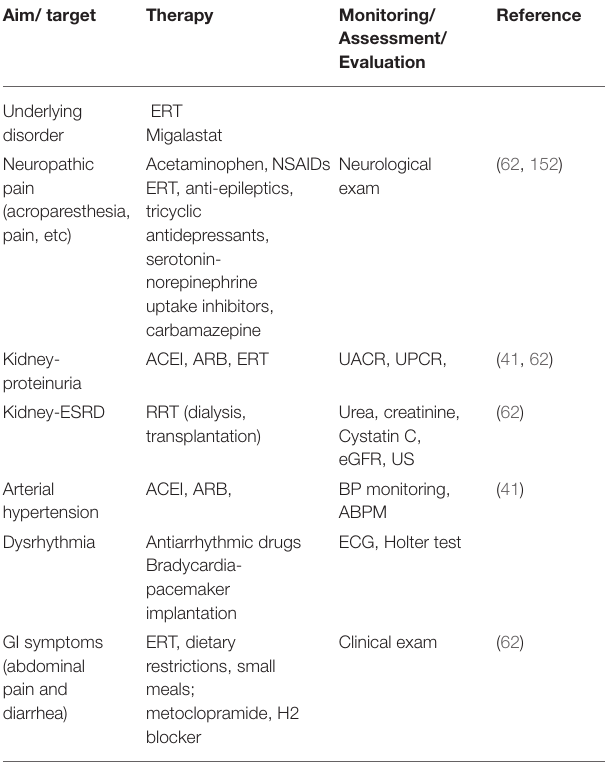
TABLE 5 | Symptomatic therapy in pediatric patients with